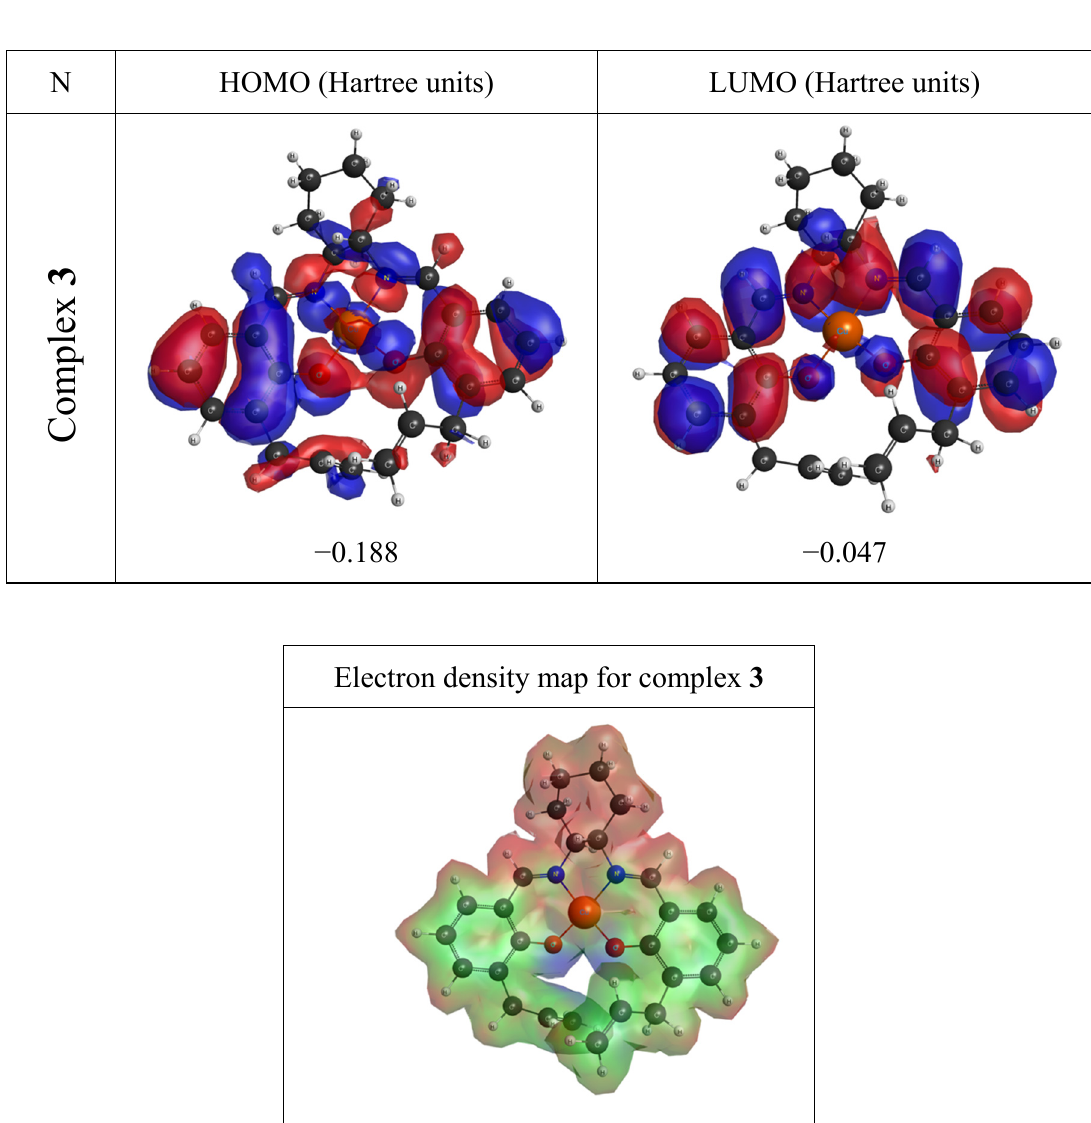
Figure 4. The electron density surfaces of complex 3 including representations of the frontier molecular orbitals ( up ) and of the molecular electrostatic potential and total electronic density ( bottom ).